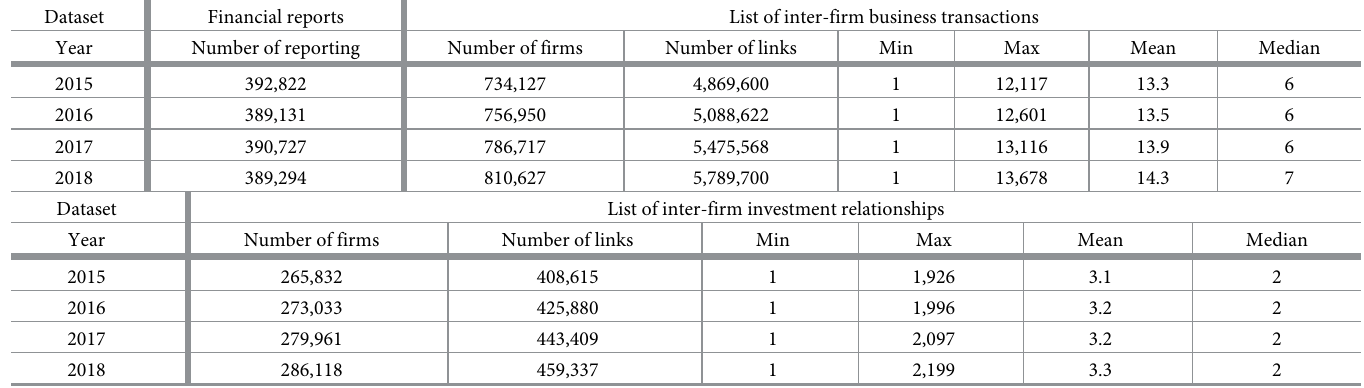
Table 1. Details of the